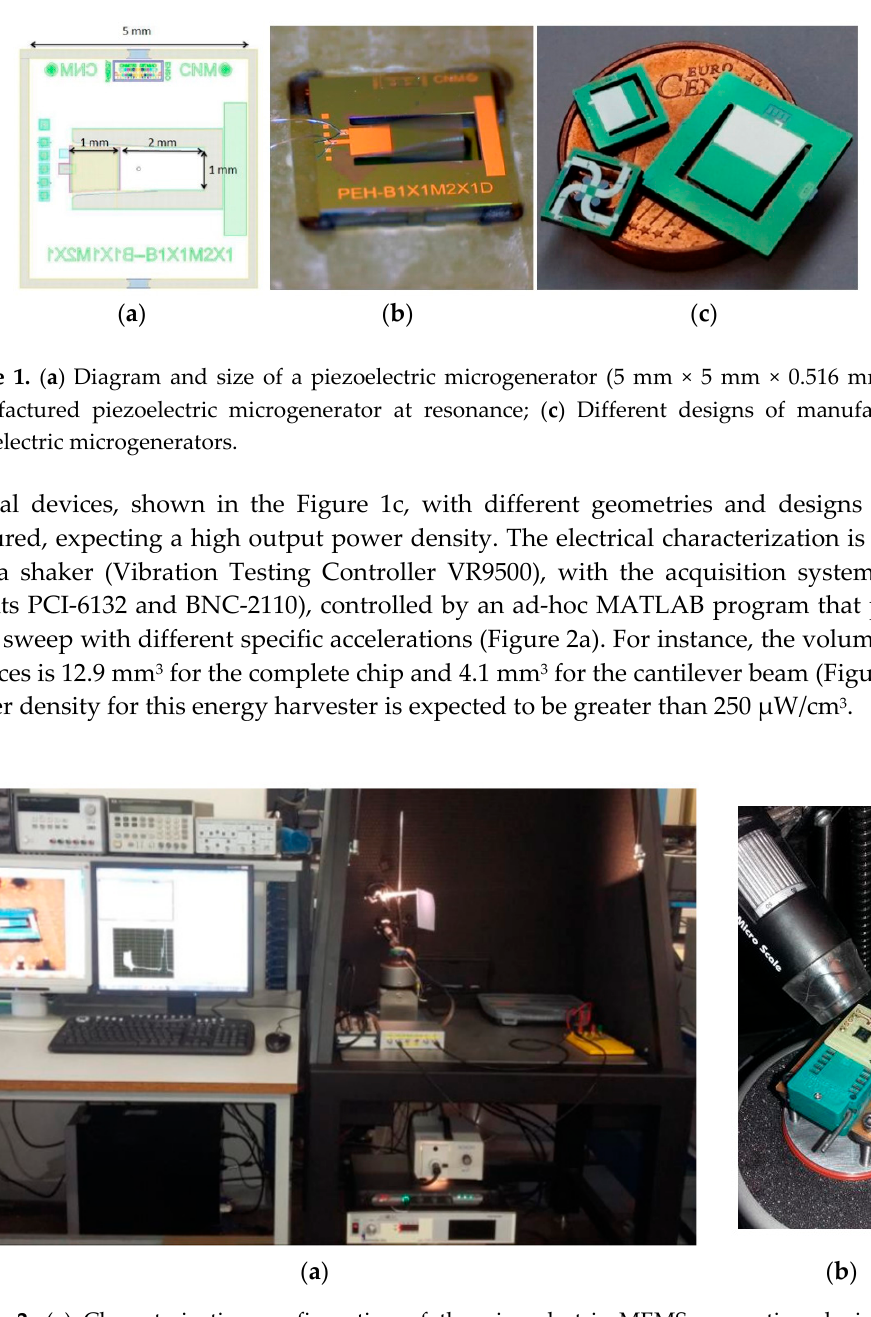
Figure 2. ( a ) Characterization configuration of the piezoelectric MEMS generating devices; ( b ) Fabricated piezoelectric microgenerator bonded to a PCB and mounted on the